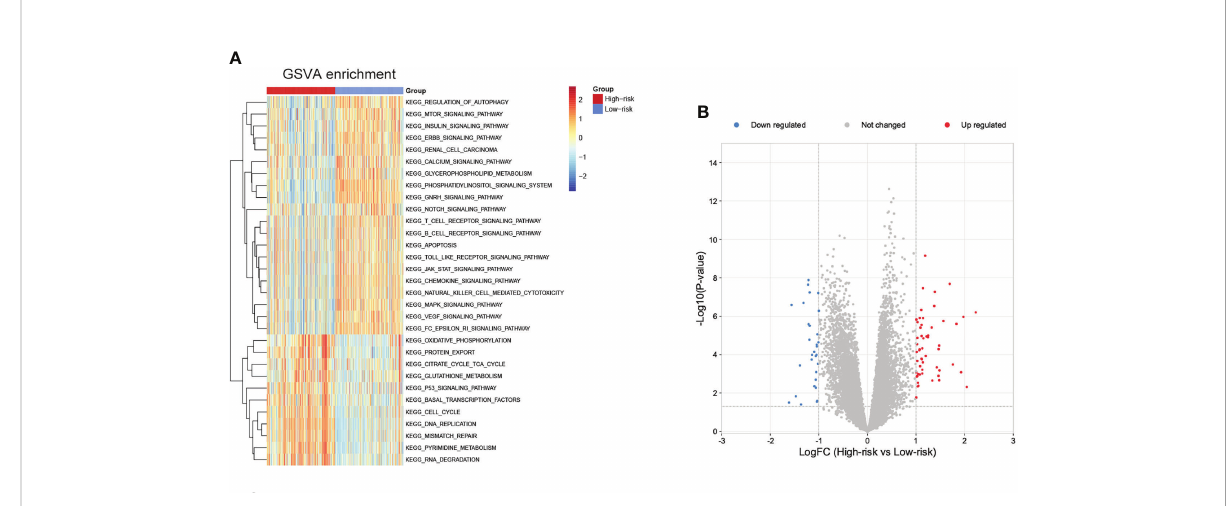
FIGURE 9 Biological pathways related to the immune signature and small molecule drugs exploration. (A) GSVA of biological pathways between the two risk subgroups. (B) Differentially expressed genes between the two risk